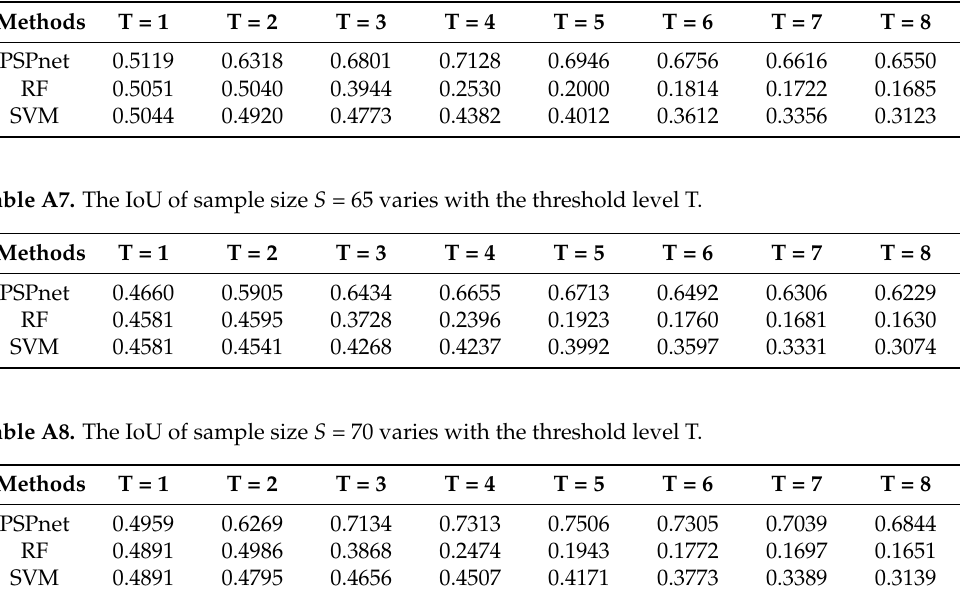
Table A6. The IoU of sample size S = 60 varies with the threshold level T.